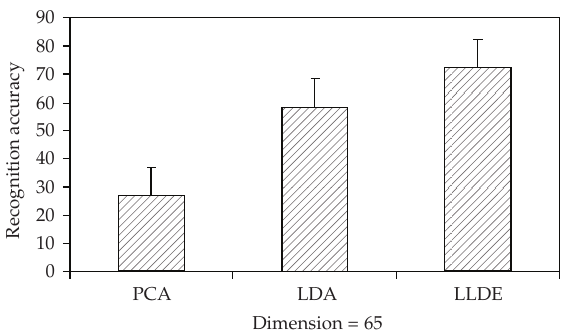
Figure 4: The average recognition rates of the PCA, LDA, and LLDE, across 10 tests (cid:2) dimension 65 (cid:3) .